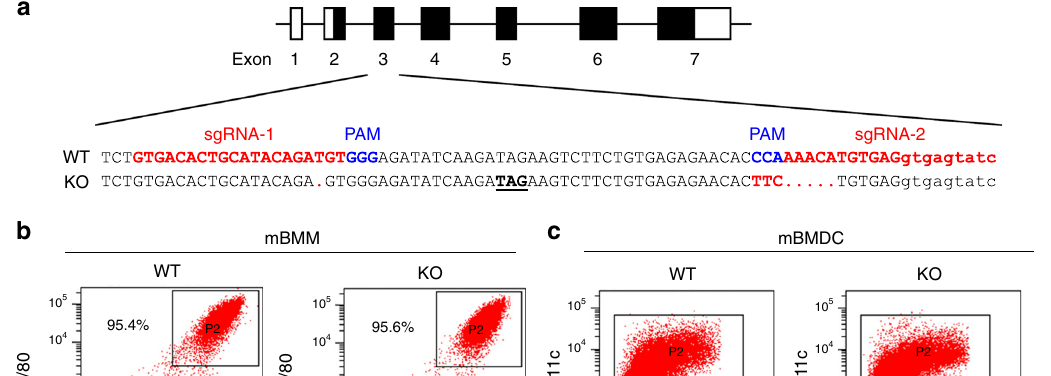
C-terminal region of CYPJ interacts with TAB2 and TAB3 . In order to identify candidate target(s) in the NF- κ B signal pathway that is/are regulated by CYPJ, a series of dual-luciferase reporter assays were performed by co-transfection of the NF- κ B reporter and proteins of the NF- κ B pathway into 293T cells with or without enforced CYPJ expression (Fig. 3a). CYPJ signi fi cantly inhibited the NF- к B reporter activation induced by TRAF6, TAK1-TAB1, TAK1- TAB2, but not NIK, p65-p50, or IKK α (SS/EE), a constitutively active mutant of IKK α (Fig. 3a). These results suggest that CYPJ